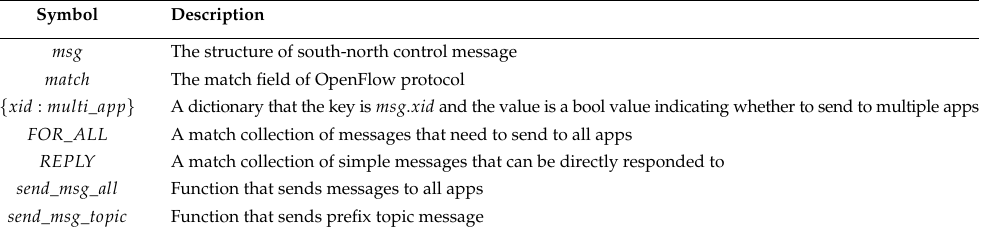
Table 1. The symbols of Algorithm